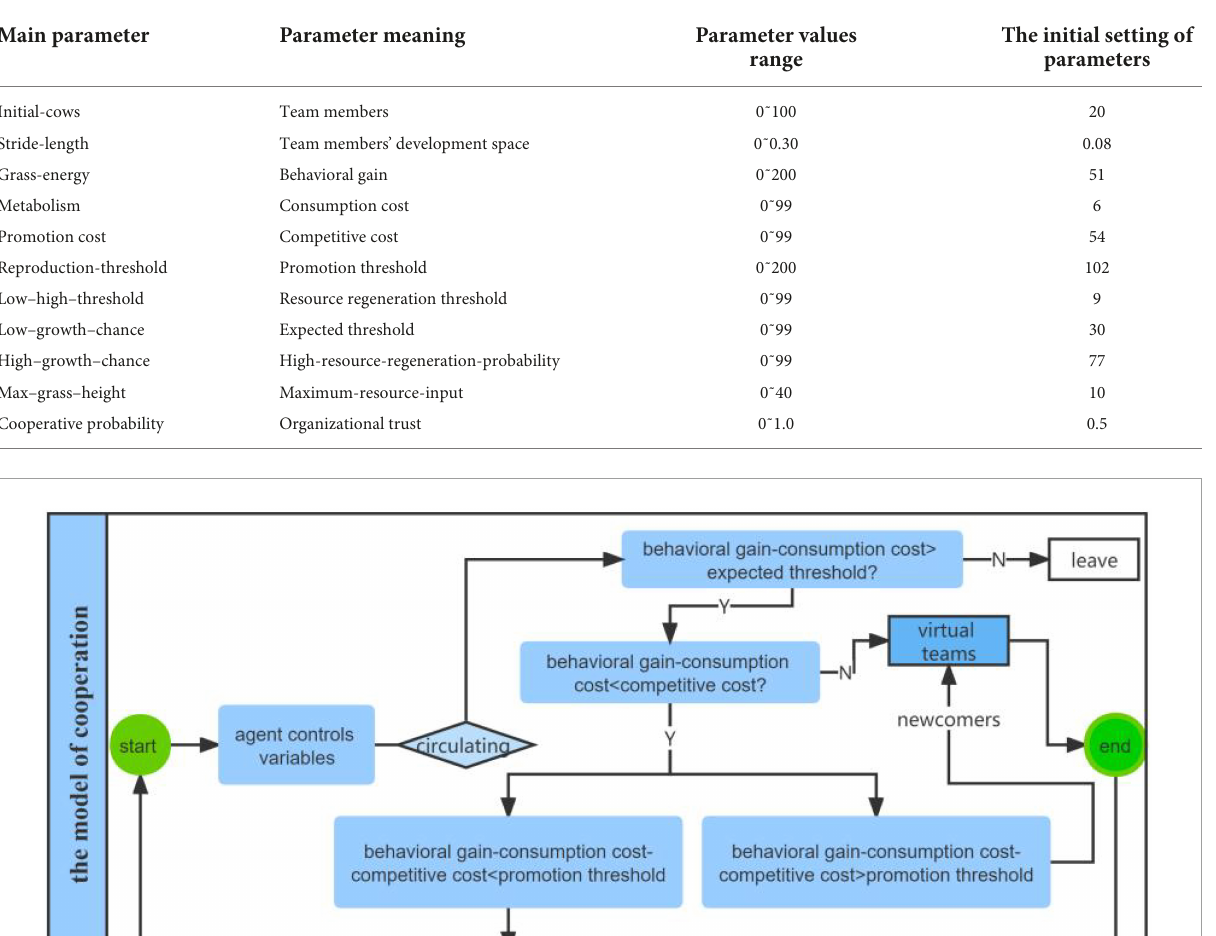
TABLE 1 The cooperation model-related parameter settings.